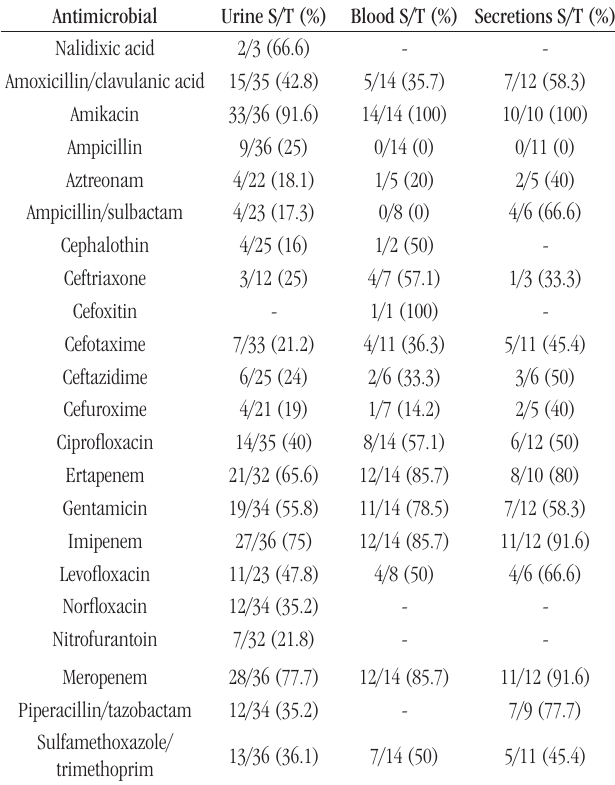
taBLE 4 − Susceptibility profile of Klebsiella pneumoniae isolated from different clinical specimens in antimicrobial testing